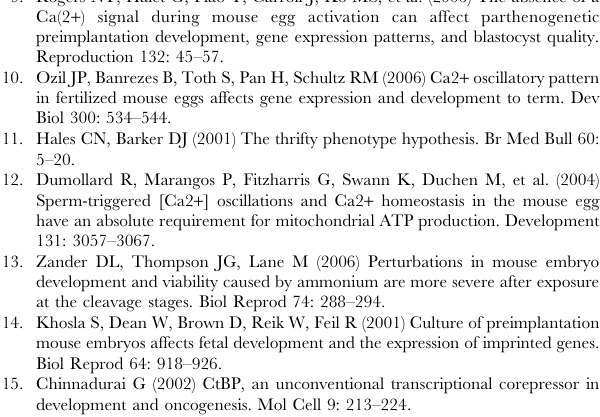
Figure S1 NAD(P)H and FAD 2 + profiles from eggs subjected to M starv for 10 or 15 h. The NAD(P)H oxidation (blue line) induced by starvation in early 20 min is thereafter amplified by prolonged duration for 10 or 15 h. The level of FAD 2 + (red line) is oxidized in early 20 min and remains oxidized at similar levels for 10 or 15 h. The records of the early 20 min are the copy from those plotted on Fig. 1A . (TIF) Figure S2 Z profiles and RWG for females issued from eggs subjected to M starv . ( A ) The upper limits of the shaded zones (grey for controls and dark pink for the experimental values) are the normalized weight profiles of females issued from the larger litter sizes (8, 7 and 6) and the lower limits, from the smaller litter sizes (5, 4, 3 and 2). ( B ) Relative weight gains (RWG) of experimental animals according to the larger or smaller litter size group. In this figure and in figures S4 and S8 , the stars in panel A denote significant differences between average experimental and control values (with a P-value at least , 0.04) when compared to controls. (TIF) Figure S3 NAD(P)H and FAD 2 + profiles from eggs subjected to M pyr for 10 or 15 h. The level of NAD(P)H oxidation (blue line), induced by M pyr in early 20 min, remains highly oxidized for 10 or 15 h. The level of FAD 2 + (red line) remains at a constant level for 10 or 15 h. The records of the early 20 min are the copy from those plotted on Fig. 2A . (TIF) Figure S4 Z profiles and RWG for females issued from eggs subjected to M pyr . ( A ) The upper limits of the shaded zones (grey for the controls and red for the experimental values) are the normalized weight profiles of females issued from the larger litter sizes (8, 7 and 6) and the lower limits, from the smaller litter sizes (5, 4, 3 and 2). ( B ) Relative weight gains (RWG) of experimental animals according to the larger or smaller litter size group. (TIF) Figure S5 NAD(P)H and FAD 2 + profiles from eggs subjected to M lac for 10 and 15 h. The level of NAD(P)H reduction (blue line), induced by M lac in early 20 min, remains highly reduced for 10 or 15 h. The level of FAD 2 + (red line) is oxidized in the early 20 min and remains oxidized at a constant